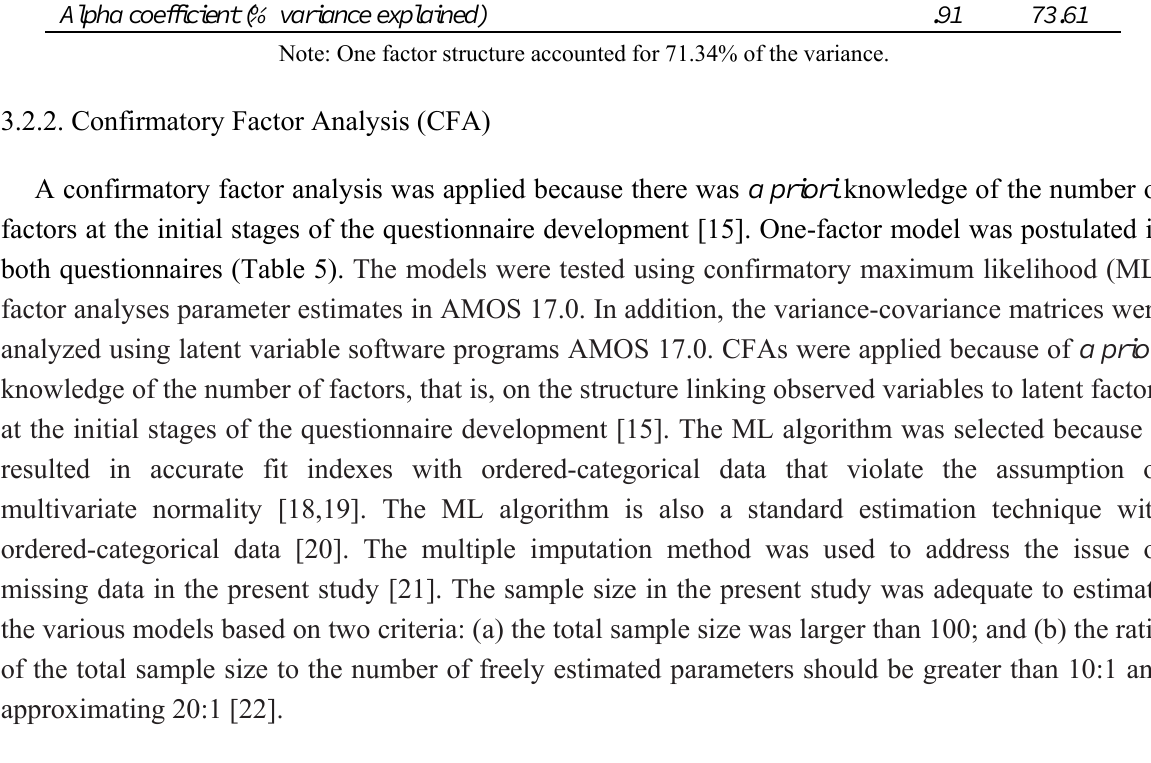
Table 5. Goodness-of-fit indices of models